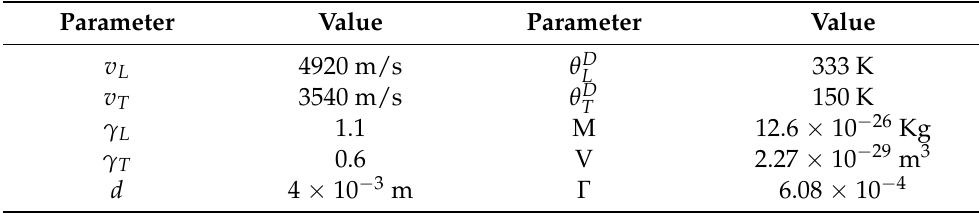
Table 2. Physical parameters for